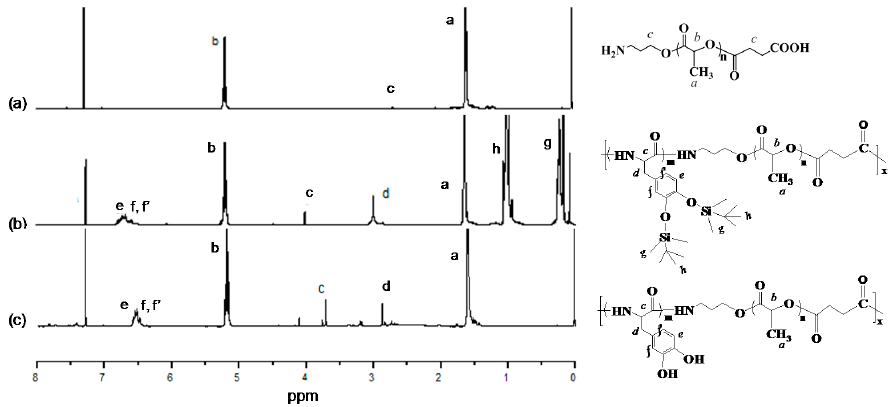
Figure 2. 1 H NMR spectra of H 2 N–PLA–COOH ( a ); PDOPA(TBDMS) 2 - b -PLA 20 ( b ); and PDOPA- b -PLA 20 ( c ). Table 2. Synthesis and characterization of the PDOPA- b -PLA copolymer.